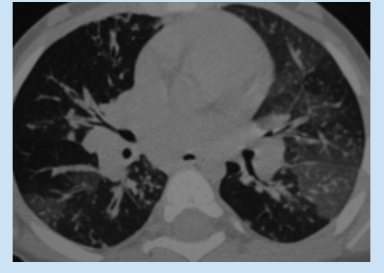
Fig.17b. Bronchiolitis obliterans.